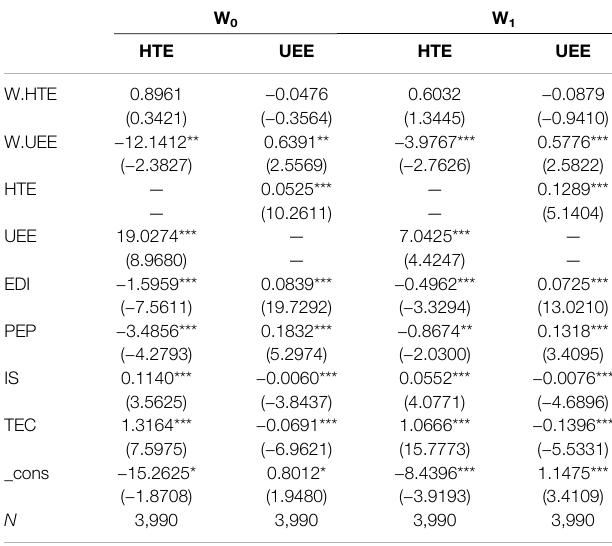
TABLE 4 | Results of full sample